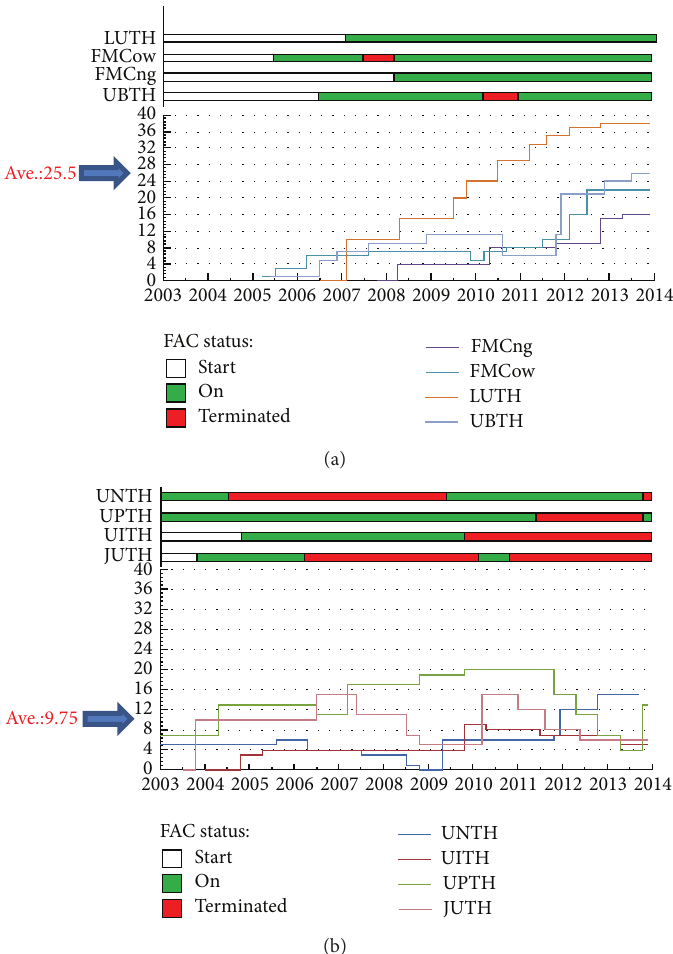
Figure 8: Incubator capacity growth or dwindle timeline. (a) Hospitals with little failure-preventive audit culture (FAC) disruption. (b) Hospitals with lengthy FAC disruption. 𝑌 -axis represented the total number of functional incubators. Neonatal centres were located at various Nigerian cities: FMCow (city of Owerri), LUTH (Idi-Araba Lagos), FMCng (Nguru), UBTH (Benin-city), UNTH (Enugu), UITH (Ilorin), UPTH (Port Harcourt), and JUTH